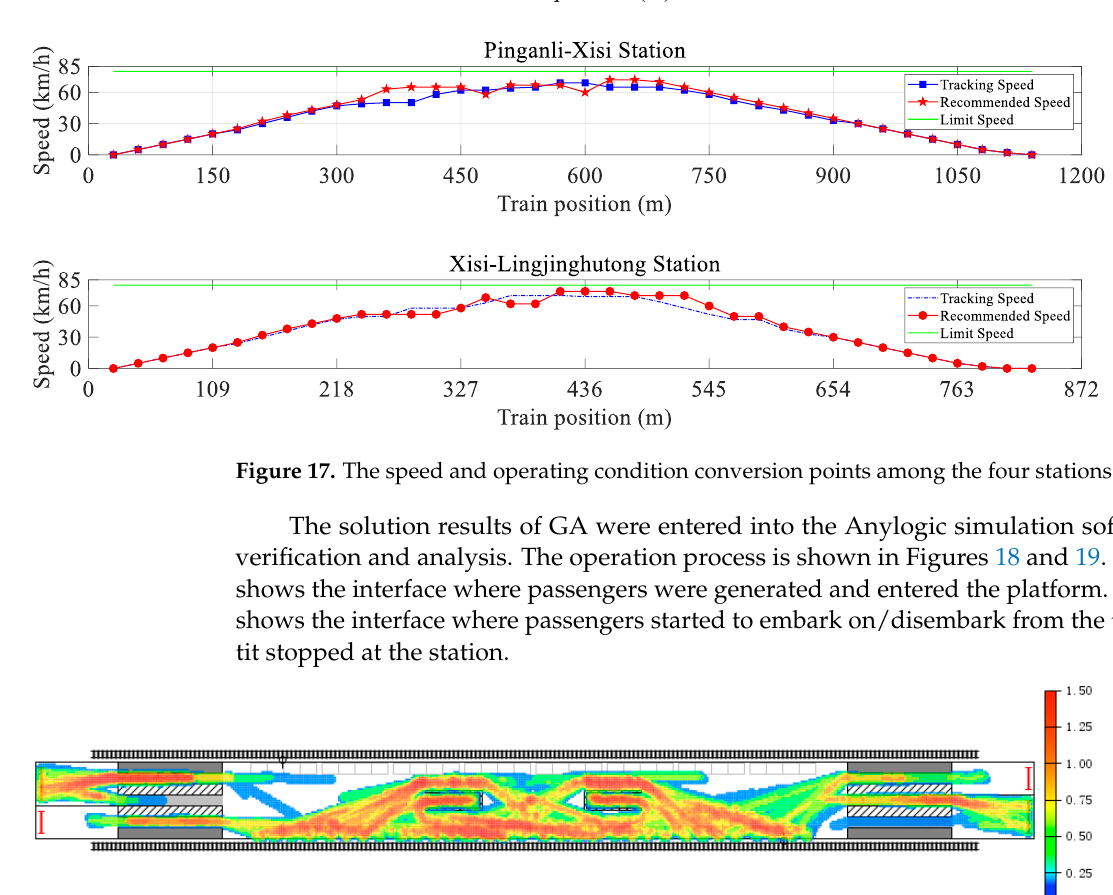
Figure 18. Passenger activity interface.